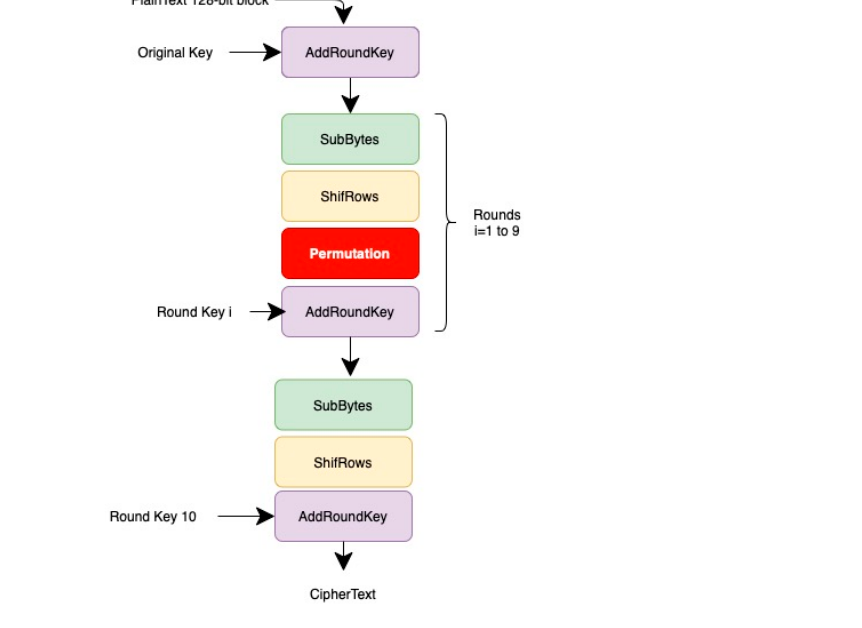
Figure 8. A lightweight AES proposal (LAES) [78] replaces MixColumns with